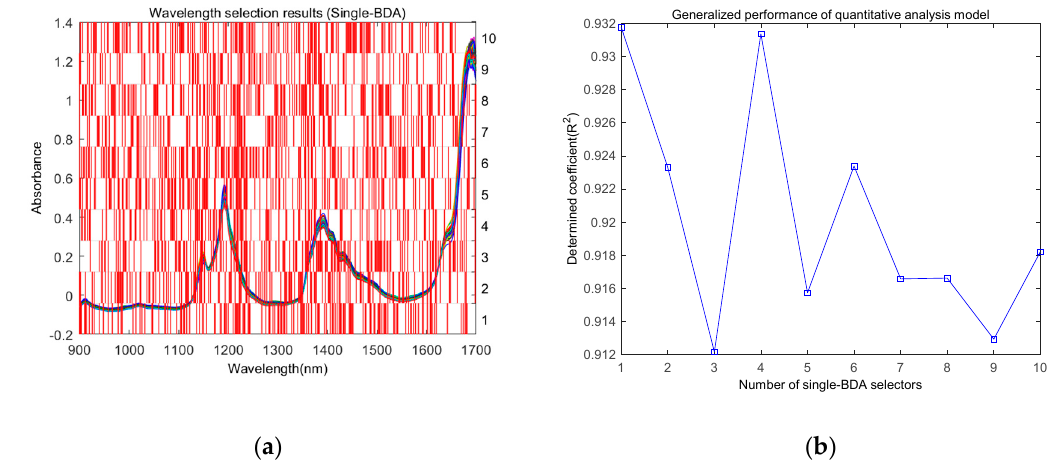
Figure 5. Wavelength selection results using the single-BDA method. ( a ) Wavelength selection results by applying a 10 times search; ( b ) corresponding generalized performance of the quantitative analysis model.